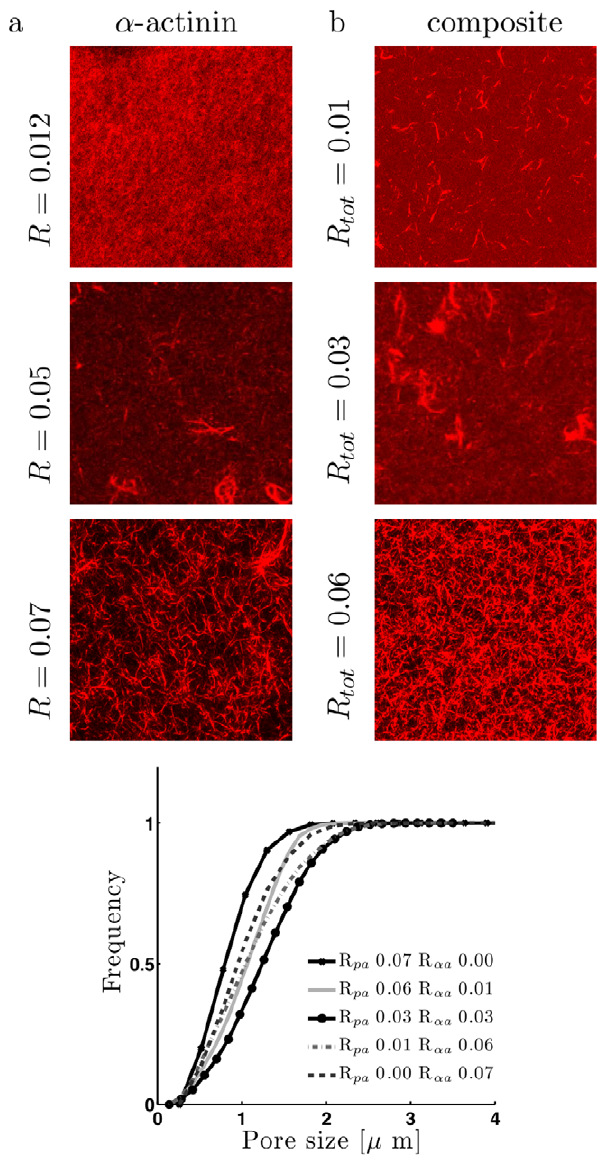
Figure 4. Structural properties of composite palladin/ a -actinin networks. Maximum intensity projections of confocal stacks of actin networks formed with (a) a -actinin and (b) mixtures of a -actinin and palladin (right column). Note the similarity to the projections of pure actin/palladin networks shown in Fig. 1. As the concentration of crosslinkers increases the networks transition from crosslinked actin filaments to bundled networks, and finally to clusters of bundles. (c) Pore size analysis of composite actin networks ( c a ~ 10 m M ). With the total crosslinker concentration held at R tot ~ : 07 , we find that addition of a small amount of palladin to a -actinin/actin increases the median pore size but pure networks have smaller pore sizes than the composite networks. Note that only two significant digits of concentration ratios are shown in legend.